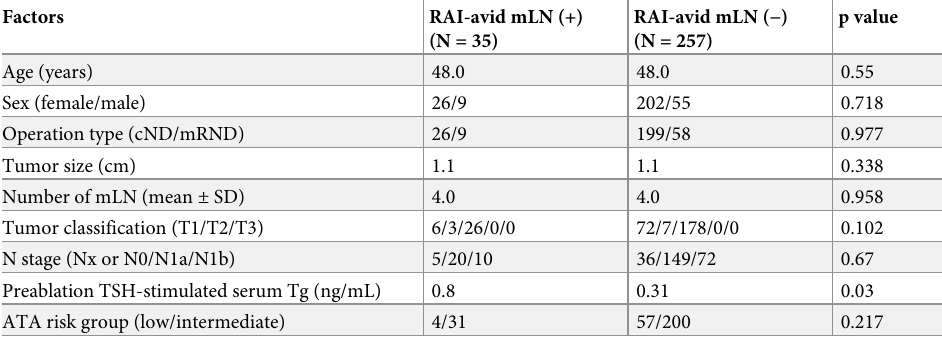
Data are presented as number (percentage) or median. cND: central neck dissection, mRND: modified radical neck